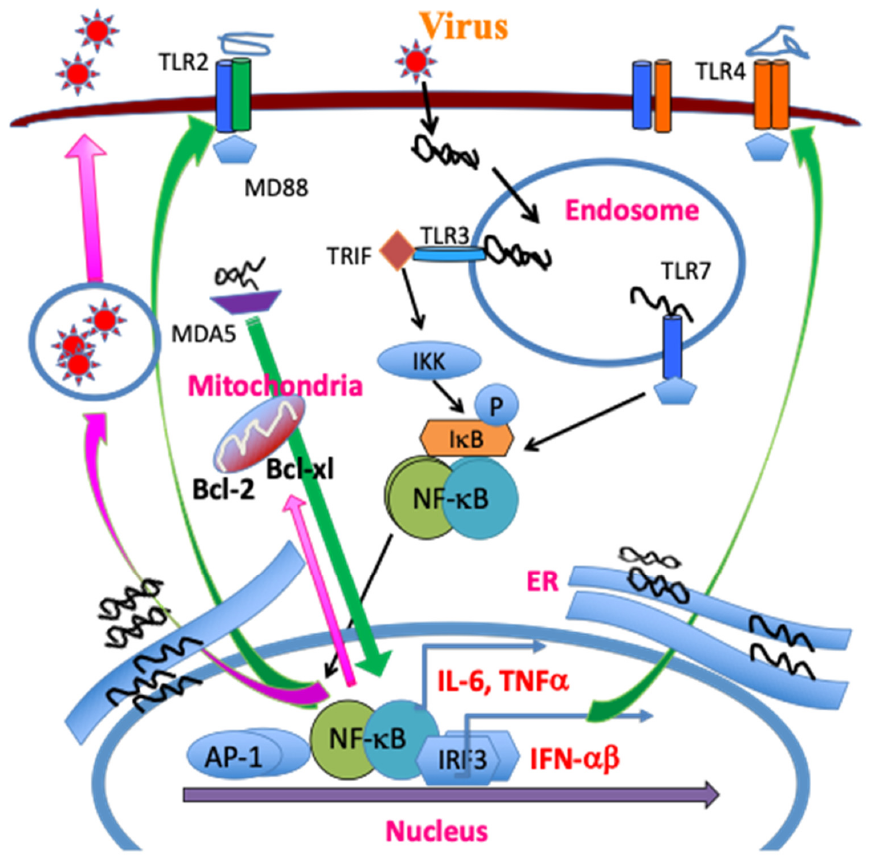
Figure 2. TMEV infection leads to release of a single stranded RNA genome and double stranded RNA replication intermediates in the endosome. The single RNA genome is recognized by TLR7, and the dsRNA intermediate, by TLR3. The TLR signaling activates NF- κ B, AP-1 and IRFs, which in turn result in the production of various cytokines. MDA5 also recognizes viral messages leading to NF- κ B activation. These activations lead to the additional expression and activation of TLR2/4, further activating NF- κ B. The amplified NF- κ B signaling promotes TMEV replication and the expression of Bcl-2 and Bcl-xL, which prevent virus-induced cellular apoptosis, increasing viral replication and cytokine production.